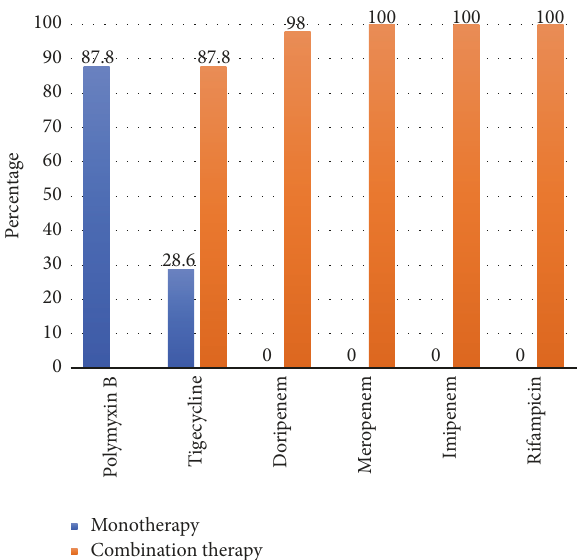
Figure 2: Bactericidal activity of all monotherapy and polymyxin B combination treatments in XDR A. baumannii [44].